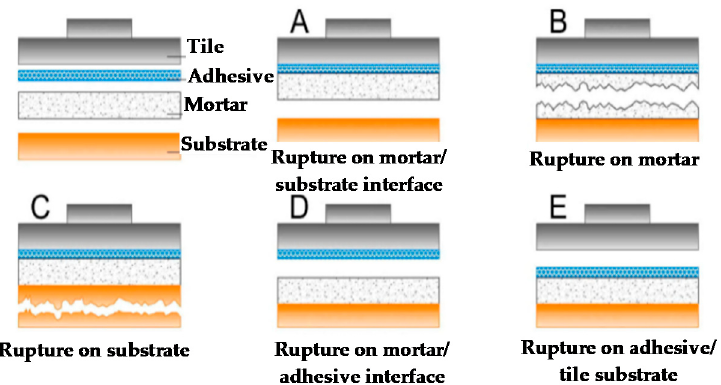
Figure 4. Types of rupture in the tensile bond strength tests: ( A ) Rupture on mortar/substrate interface, ( B ) Rupture on mortar, ( C ) Rupture on substrate, ( D ) Rupture on mortar/adhesive interface and ( E ) Rupture on adhesive/tile interface.